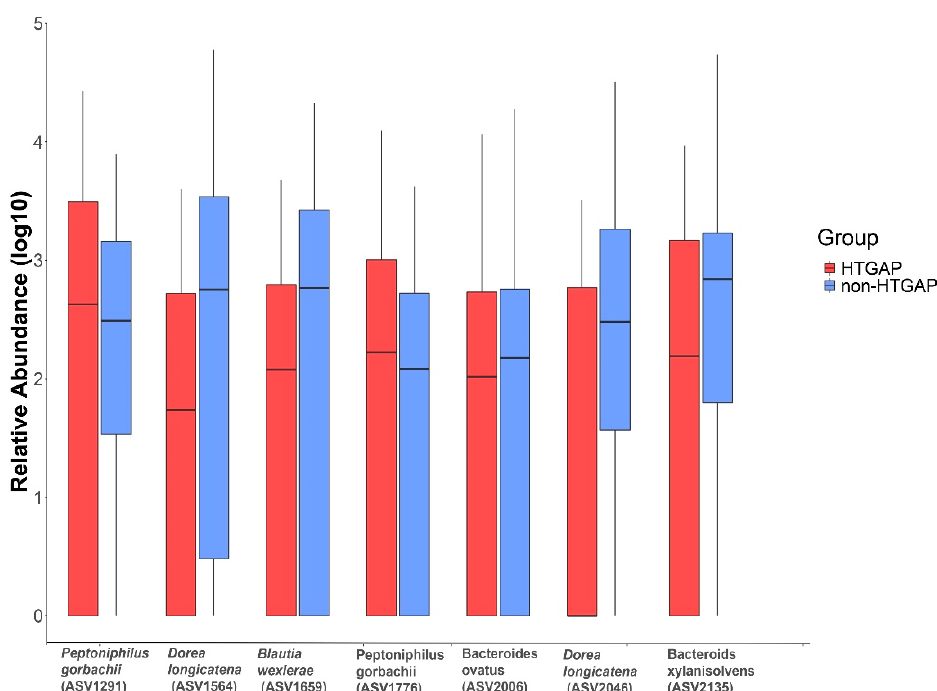
Figure 4. Relative abundances of differential ASVs between HTGAP and non-HTGAP groups. Box-plot features represent the median (central line), upper and lower quartiles (box), and the maximum and minimum values of the data (bars). HTGAP, hypertriglyceridemia-associated acute pancreatitis; ASV, amplicon sequence variants.